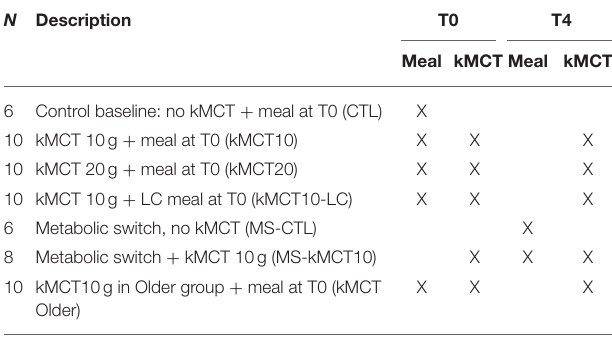
TABLE 1 | Summary of the metabolic interventions.